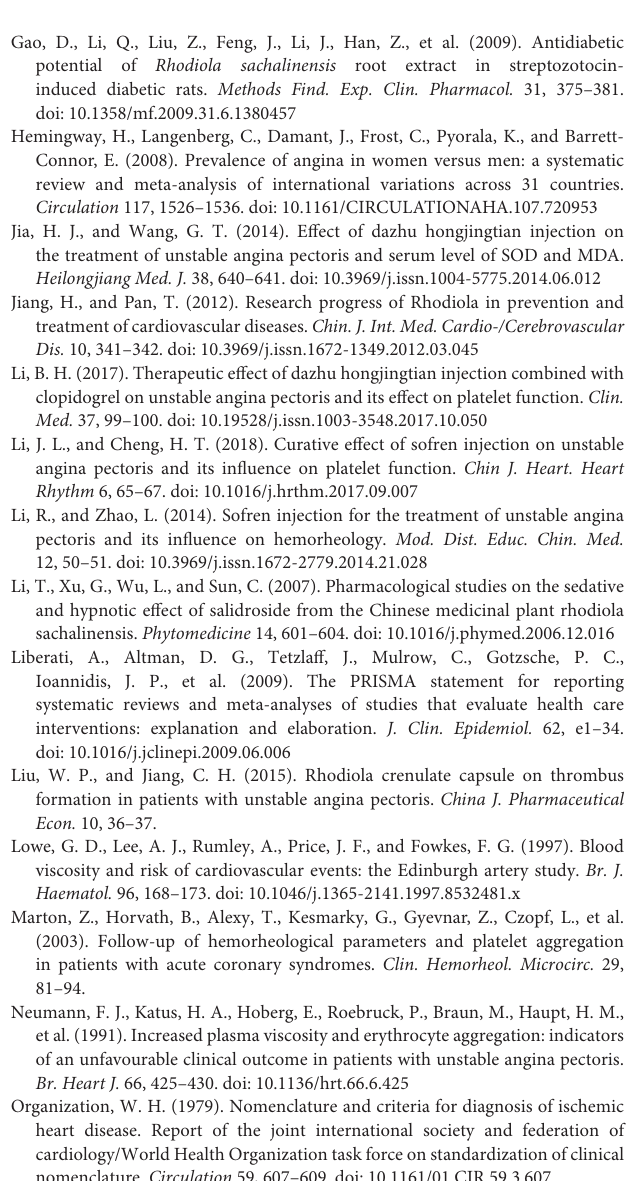
Figure S1 | Risk of bias graph (A) and risk of bias summary (B) . Figure S2 | Funnel plots of trial reporting ≥ 80% reduction in frequency of angina attacks. Figure S3 | Funnel plots of trial reporting marked improvement of abnormal